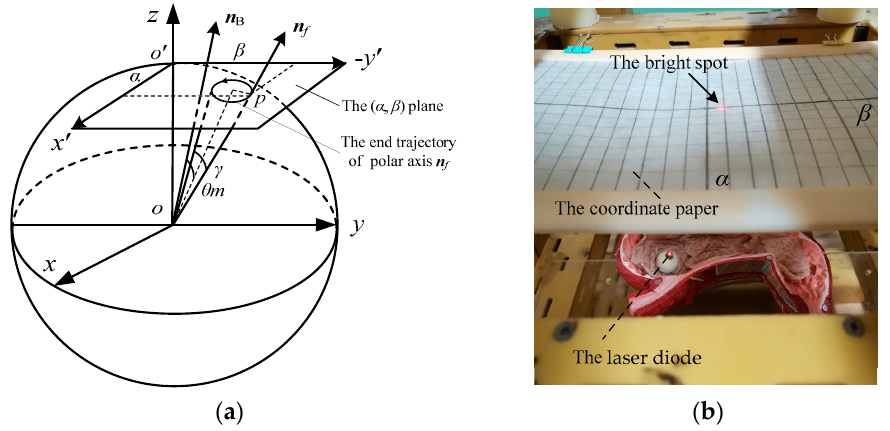
Figure 16. The orientation measuring device of the polar axis n f . ( a ) The schematic diagram; ( b ) The physical diagram.